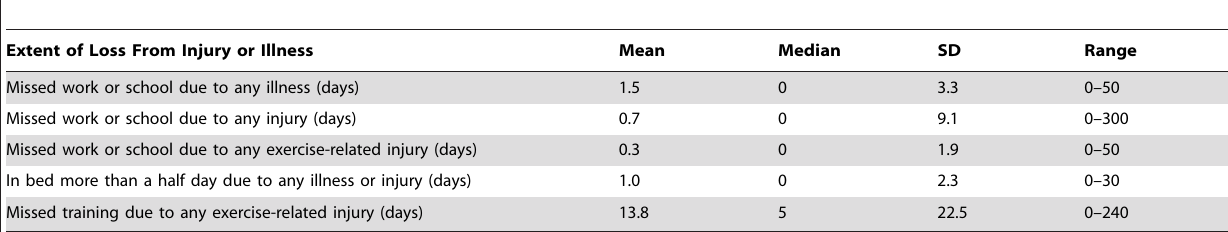
Table 2. Lost time from work or school and from training due to illness and injury during the prior 12 months among 1,212 active ultramarathon runners.